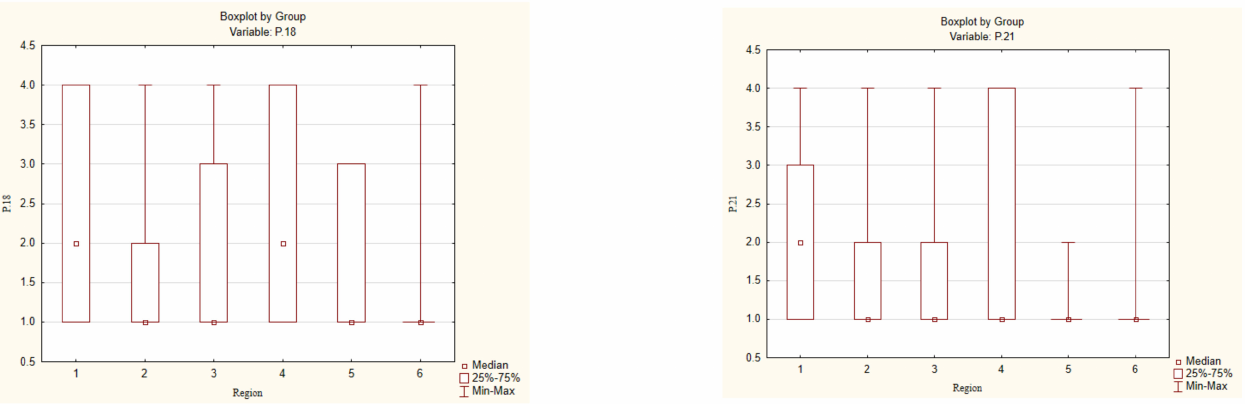
Figure 8. Box and whisker diagrams for practice P18 (category “Water saving”) and P21 (category “Waste management”).